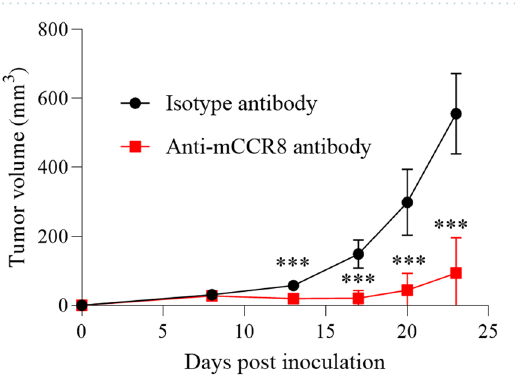
Figure 6. Suppressive effect of induced CCR8+ Tregs on CTL function. Tregs were purified from healthy donors and expanded. ( A ) Expression of Treg-related molecules on induced CCR8+ Tregs and CCR8− Tregs was analyzed by flow cytometry (n = 8). ( B ) CCR8+ Tregs and CCR8− Tregs were sorted and co-cultured with CD8 T cells prepared from healthy donor PBMCs in the presence of anti-CD3 antibody and APCs for 4 to 6 days. The expressions of GZMB and perforin in CD8 T cells were detected by flow cytometry (n = 7). The values were normalized to the percentage of GZMB or perforin expression in CD8 T cells cultured without Tregs set as 100%. ( C ) Antigen non-specific cytotoxicity of CD8 T cells after co-culture with Tregs was evaluated. CD8 T cells were co-cultured with anti-CD3scFv-expressing BALL-1 cells (aCD3-BALL-1 cells) (E:T ratio = 1:1) for 24 h; dead target cells were detected as propidium iodide (PI) + cells by flow cytometry (n = 6). The cytotoxic activities were calculated and normalized to the value of PI+ aCD3-BALL1 cells cultured with CD8 T cells without Tregs set as 100%. ( D ) Antigen-specific cytotoxicity of CTLs after co-culture with Tregs was evaluated. Mart-1 tetramer–positive CTLs were co-cultured with sorted CCR8+ Tregs or CCR8− Tregs for 4 to 6 days and then co-cultured with SK-MEL-5 cells (E:T ratio = 1:1) for 24 h. After lymphocytes were removed, WST assay was performed (n = 7). The cytotoxic activities were calculated and normalized to the cell viability of SK-MEL-5 cells cultured with CTLs without Tregs set as 100%. Statistical significance was determined by paired t-test (* p ≤ 0.05; ** p < 0.01). Data are shown as mean values ± SD.